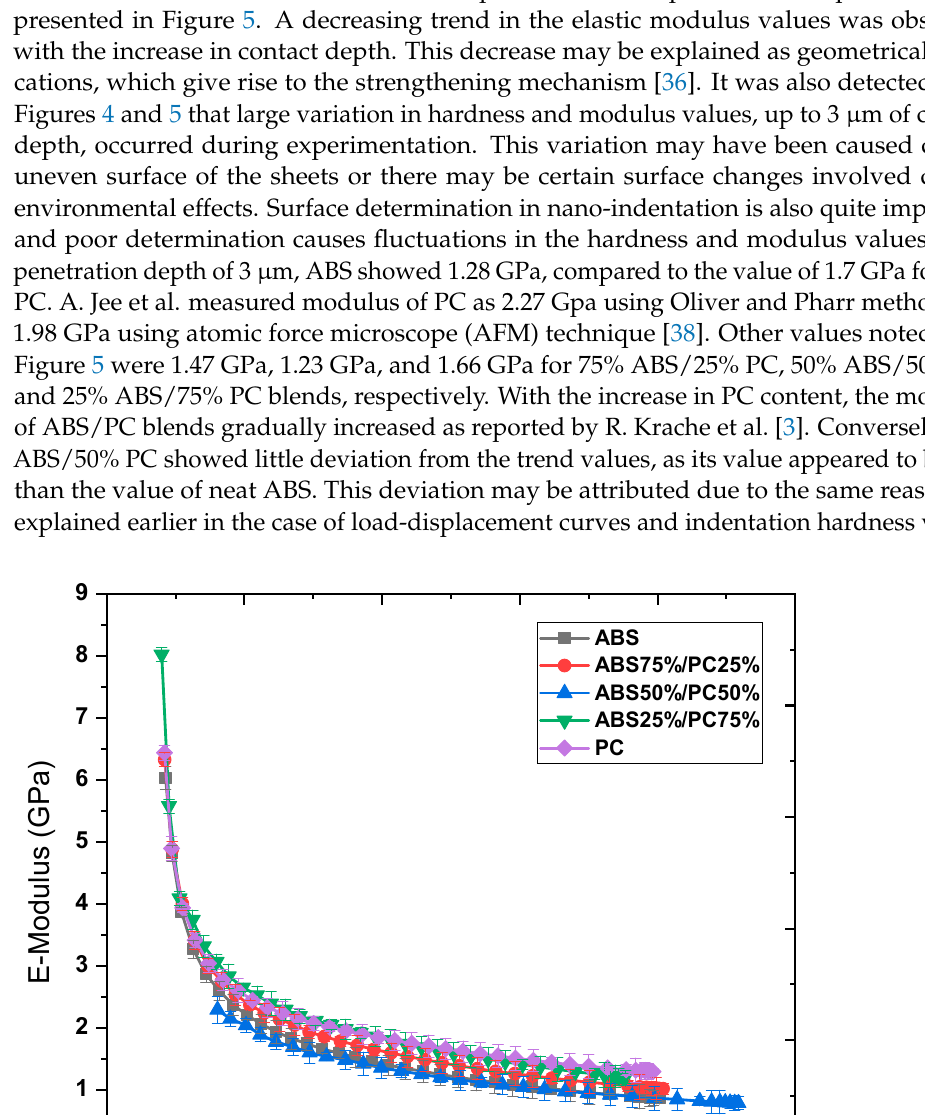
value of ABS due to an increase in the amount of